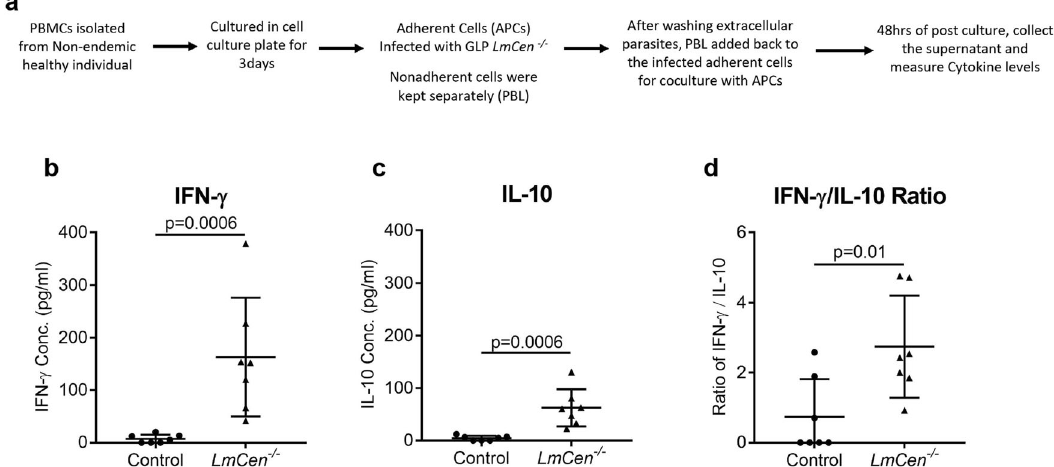
Fig. 7 GLP-grade LmCen − / − induce host pro-in fl ammatory immune response in human PBMCs. a Schematic representation of experiment plan to determine immune response of LmCen − / − in human PBMCs. b – d Scatter dot plots showing the levels (pg/ml) of pro-in fl ammatory (IFN- γ ) ( b ) and